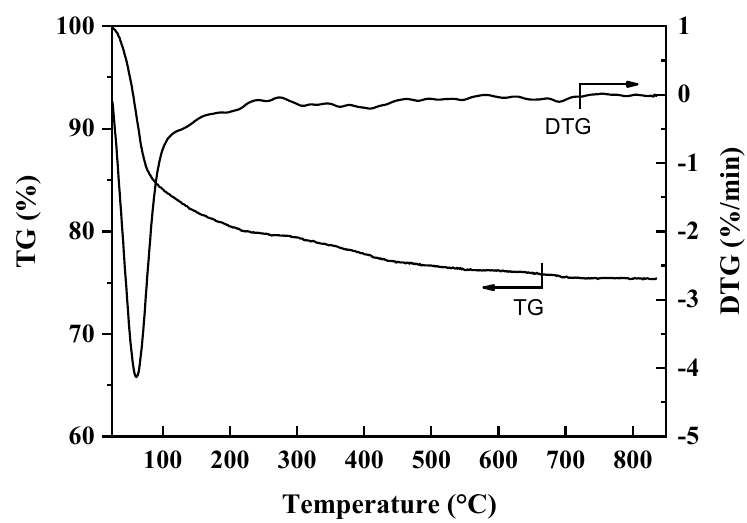
Figure 5. Thermogravimetric (TG) and Derivative Thermogravimetric (DTG) curves of paste after 28 days of curing.